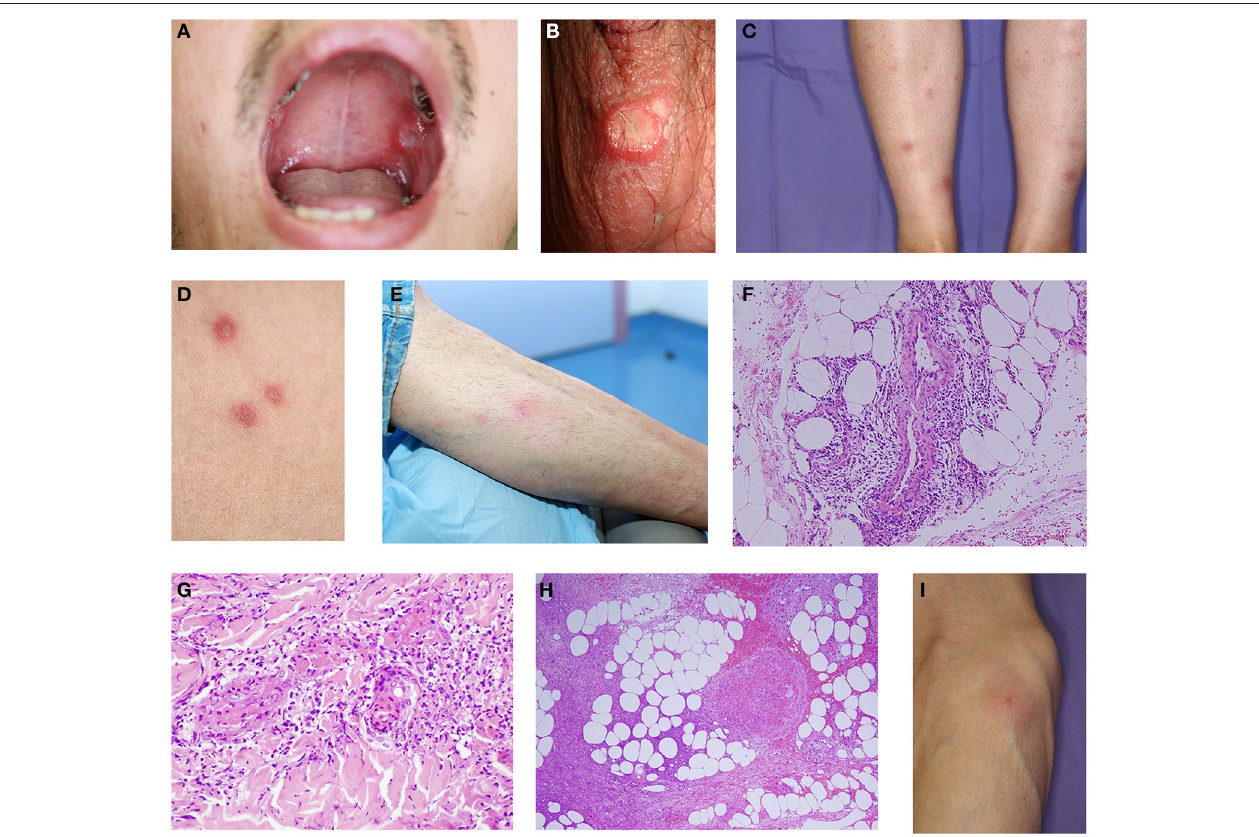
FIGURE 1 | (A) Oral ulcer on the buccal mucosa with rolled borders and grayish necrotic base. (B) Genital ulcer with yellowish necrotic tissue on the scrotum. The genital ulcer is deep and surrounded by erythema. The scrotum is the site most commonly involved in the male. (C) Erythema nodosum-like lesions on the lower leg. A painful, reddish erytemanous nodule is detected in the pretibial lesion. (D) Papulopustular folliculitis are sterile pustules on the erythematous base of the trunk. (E) Superficial thrombophlebitis is erythematous tender subcutaneous nodules arranged in a linear fashion on the leg. (F) Histological feature of erythema nodosum-like lesion includes a dense neutrophil infiltrate around the vessels in the subcutaneous tissue. (G) Histological feature of papulopustular lesion includes a leukocytoclastic vasculitis with neutrophil infiltrate in the dermis. (H) Histology of thrombophlebitis shows vascular thrombus and lymphocytic infiltrate in a subcutaneous vein. (I) Skin pathergy reaction is a pustule formation at the needle site after 24h on the forearm. (A,F,H,I) are derived from Nakamura et al. (3, 4).